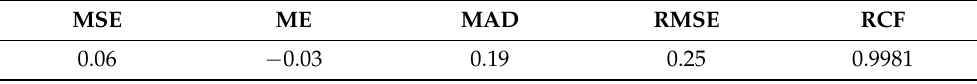
Table 9. Evaluation metrics of SpO 2 for the single PD reflection-type wrist model.